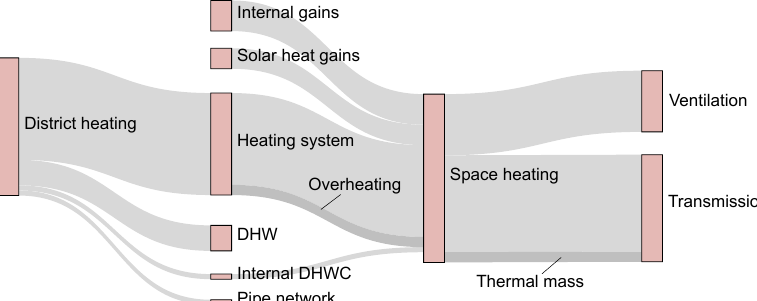
Figure 1. Typical heat balance of a district heating-connected Swedish multifamily building: The height of the gray areas indicates relative share of total heat flow over the heating season. Darker gray areas show 1. overheating due to imperfect control and 2. net contribution from charging and discharging the thermal